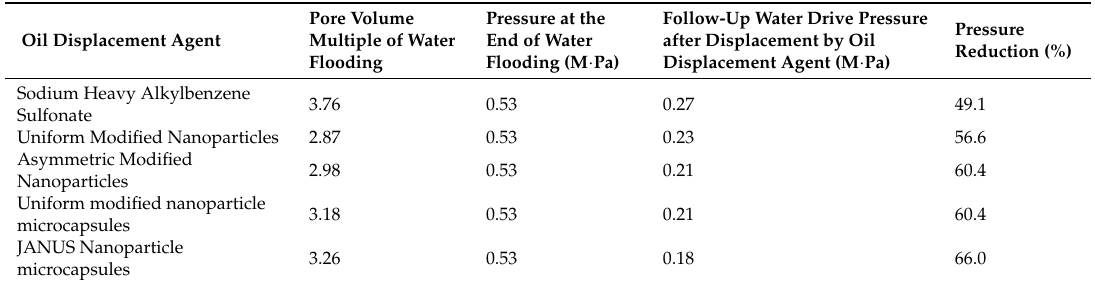
Table 3. Laboratory experimental results on reducing displacement pressure of surface core.